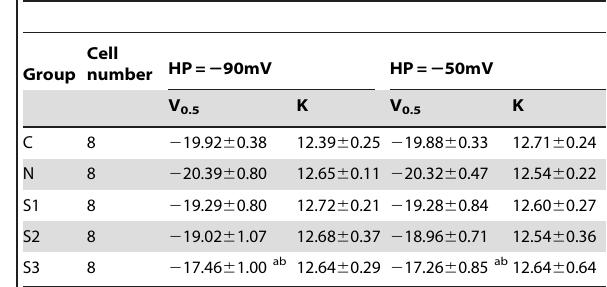
Table 3. The voltage of half-inactivation (V 0.5 )and slope factor(k) at HP of 2 90mv and 2